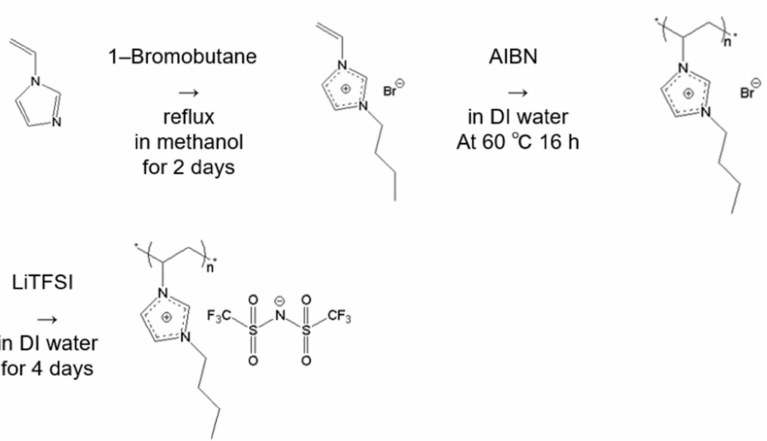
Figure 3. The step for synthesis of poly(1-butyl-3-vinylimidazolium bis(trifluoromethanesulfonyl) imide (PC 4